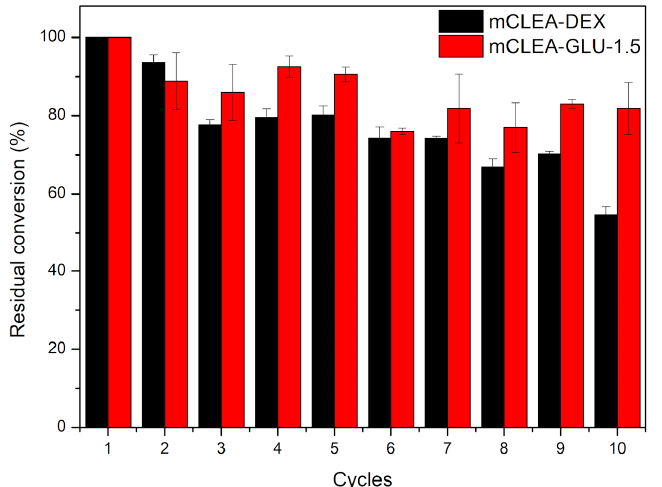
Figure 4. Operational stability of mCLEA-GLU-1.5 and mCLEA-DEX of β -galactosidase from As- pergillus oryzae during 10 cycles of 60 min operation. Subsequent batches of lactose hydrolysis were carried out in a potassium phosphate buffer (pH 6.6), with 0.1 mM Ma nCl 2 as a cofactor, at 37 °C, using lactose 164 mM (substrate).